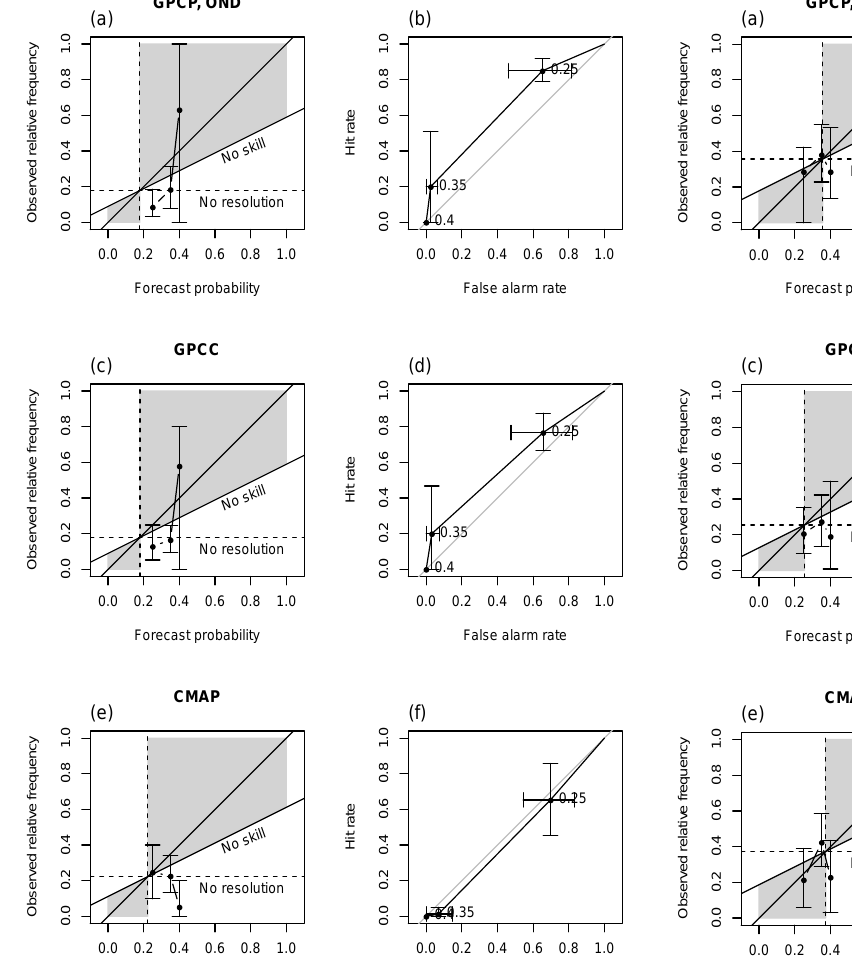
Figure 3. The attributes diagrams and the ROC curves for early season forecasts, based on different data sets for verification. The confidence intervals are calculated using the block bootstrap ( n = 15000).